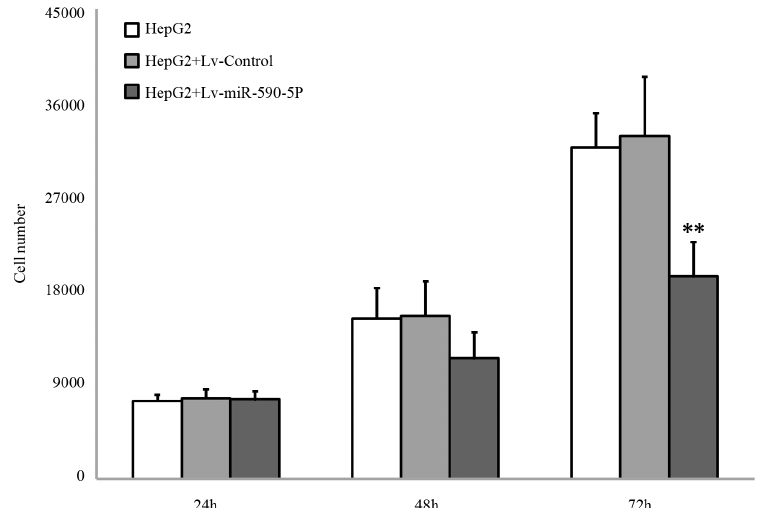
Figure 4. Effect of Lv-miR-590-5P on cell growth of HepG2 cells. HepG2 cells were infected by Lv-miR-590-5P or Lv-Control. The infected cells were reseeded to 96-wells plates. After incubation for indicated hours, the number of cells were detected by CCK-8 assay. The values represent the means ± SD ( n =